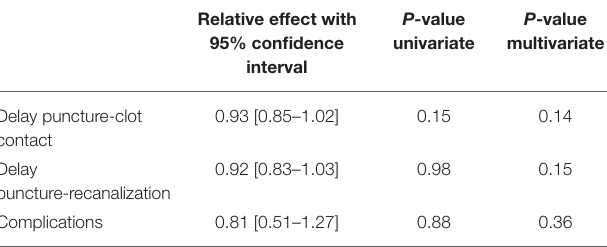
TABLE 3 | Results of multivariate analysis: relative effect of performing gadolinium-enhanced extracranial MRA on puncture-clot contact, puncture-recanalization, and procedural complications.